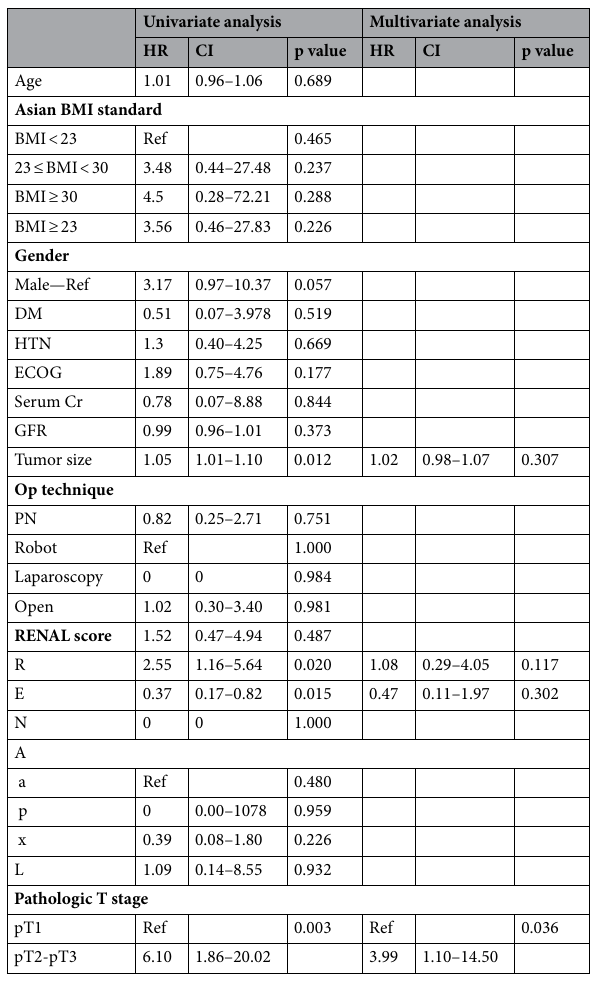
Table 2. Univariate and multivariate analysis for recurrence after nephrectomy. BMI body mass index, DM diabetes mellitus, HTN hypertension, ECOG Eastern cooperative oncology group performance status, GFR estimated glomerular filtration rate, Op operation, PN partial nephrectomy, RENAL score RENAL nephrometry score, R radius (maximal diameter), E exophytic/endophytic, N nearness to collecting duct system/renal sinus, A anterior/posterior location, L location relative to the polar lines, HR hazard ratio, CI confidence interval, Ref